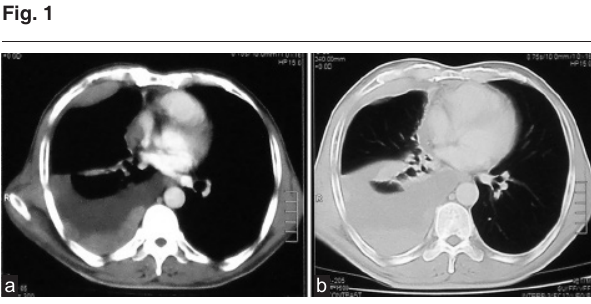
a b (a) Computed tomography (CT) of the chest mediastinal view showing right-sided free pleural effusion with pleural-based mass with partial underlying lung collapse. (b) CT of the chest pulmonary window showing right-sided free pleural effusion with partial underlying lung collapse.